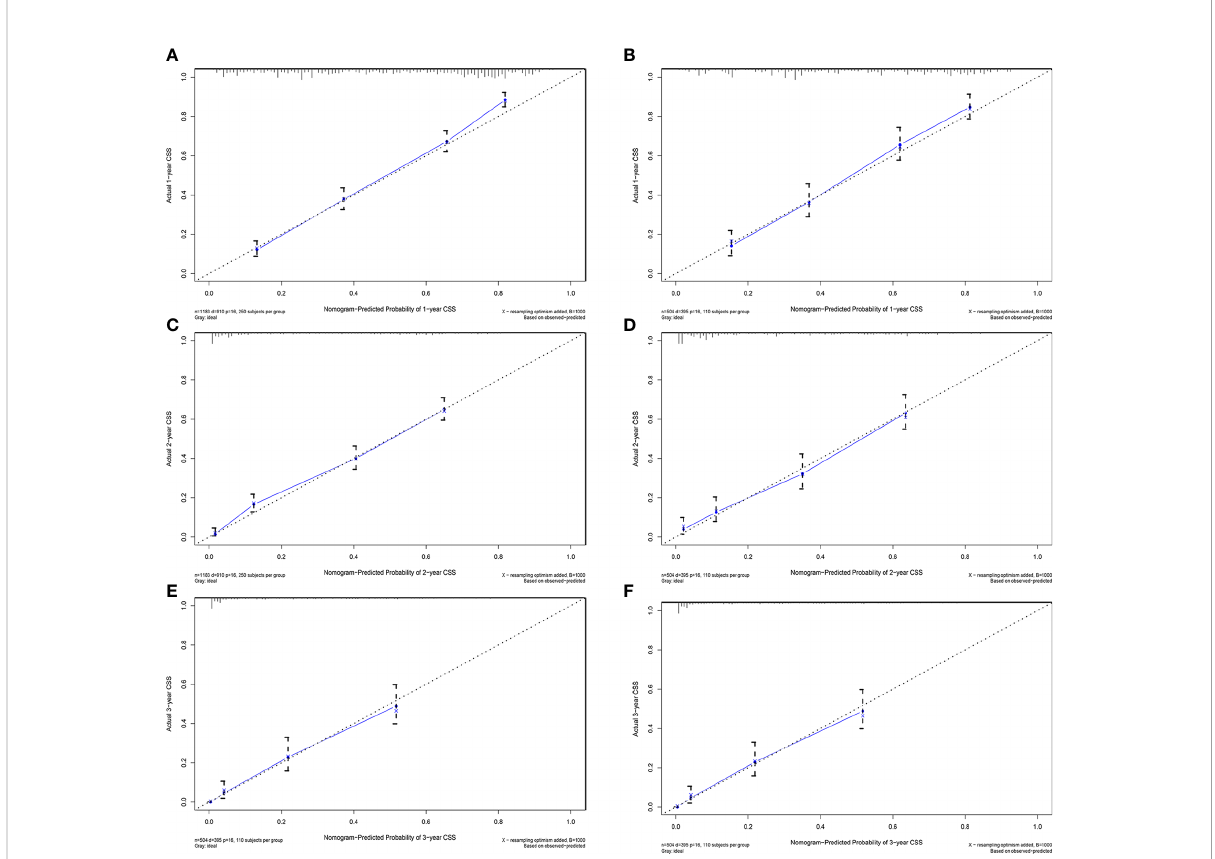
FIGURE 5 Calibration plots of 1-year, 2-year, and 3-year CSS for ECCA patients. (A, C, E) Calibration plots of 1-year, 2-year, and 3-year CSS in the training cohort. (B, D, F) Calibration plots of 1-year, 2-year, and 3-year CSS in the training cohort. CSS, cancer-speci fi c survival.